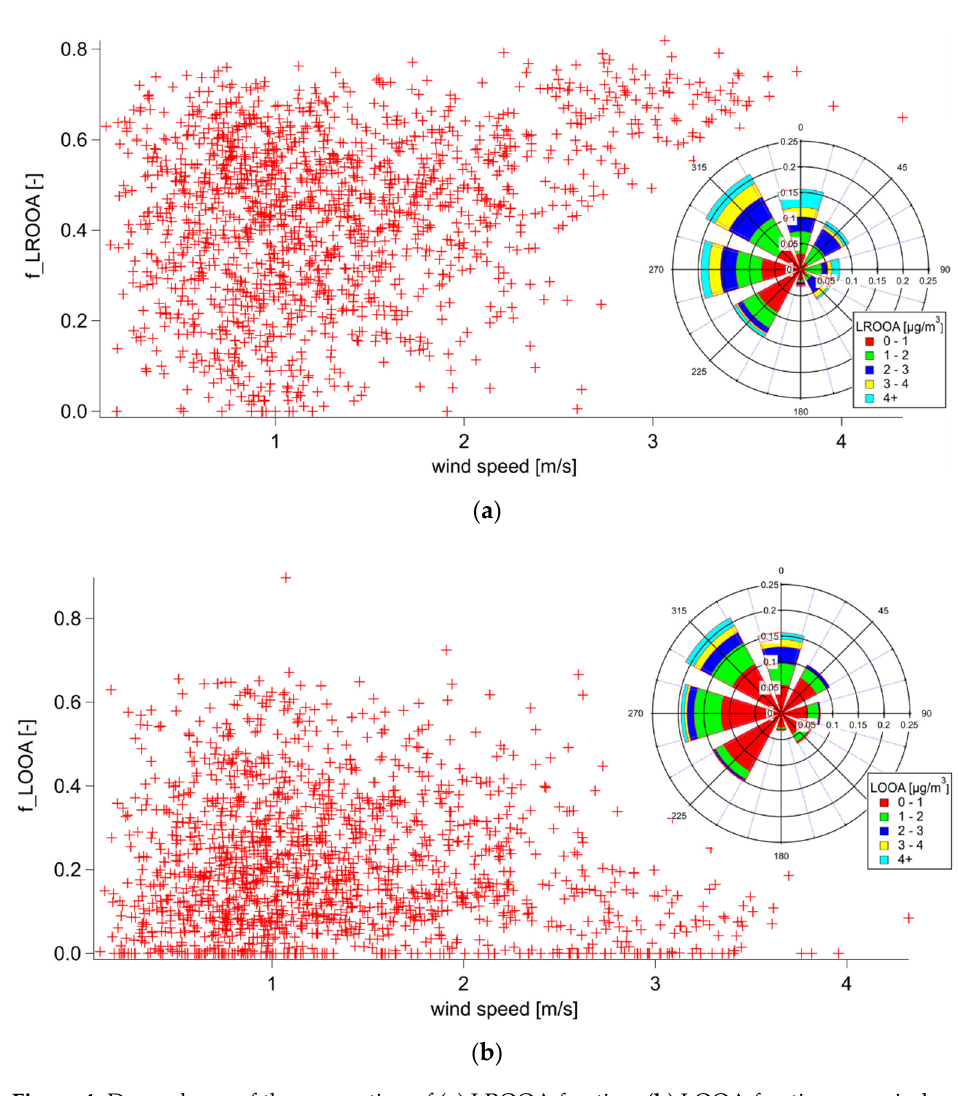
Figure 4. Dependence of the proportion of ( a ) LROOA fraction; ( b ) LOOA fractions on wind speed. Fractions are obtained as a proportion of a factor to the total mass of all factors. The graphs also contain wind roses showing the directionality of the factors.